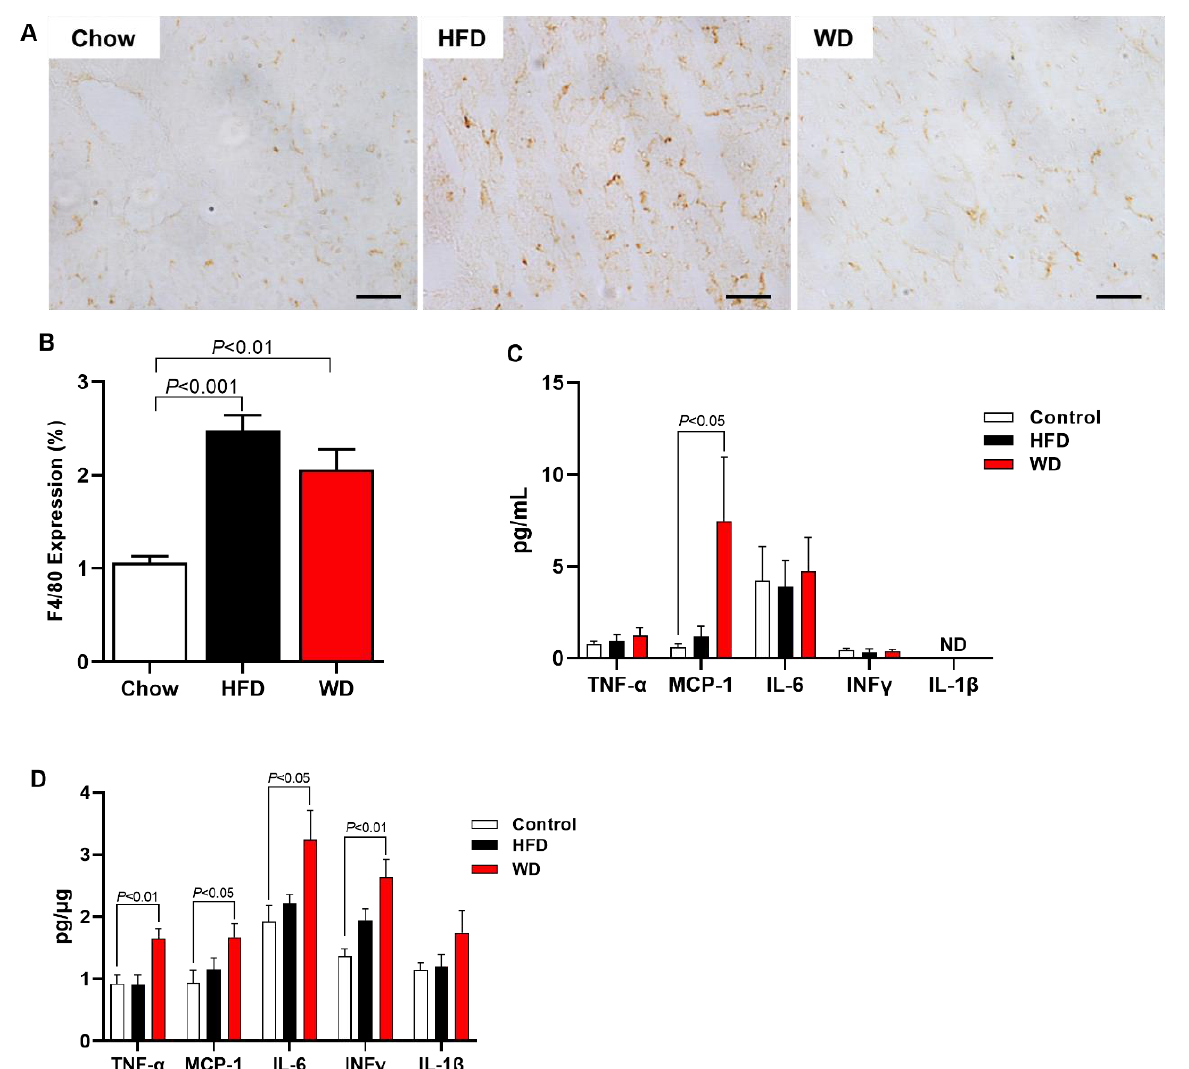
Figure 4. ApoE KO Mice fed an HFD or WD displayed increased hepatic inflammation. Representa- tive images of F4/80 expression (scale of 50 µ m, objective 40 × ) ( A ). Hepatic inflammation represented for F4/80 expression (macrophage activity marker) ( B ). Plasma cytokine level ( C ). Hepatic cytokine level ( D ). Data are represented as mean ± SEM (N = 5–9). The statistical differences as indicated by one-way ANOVA.